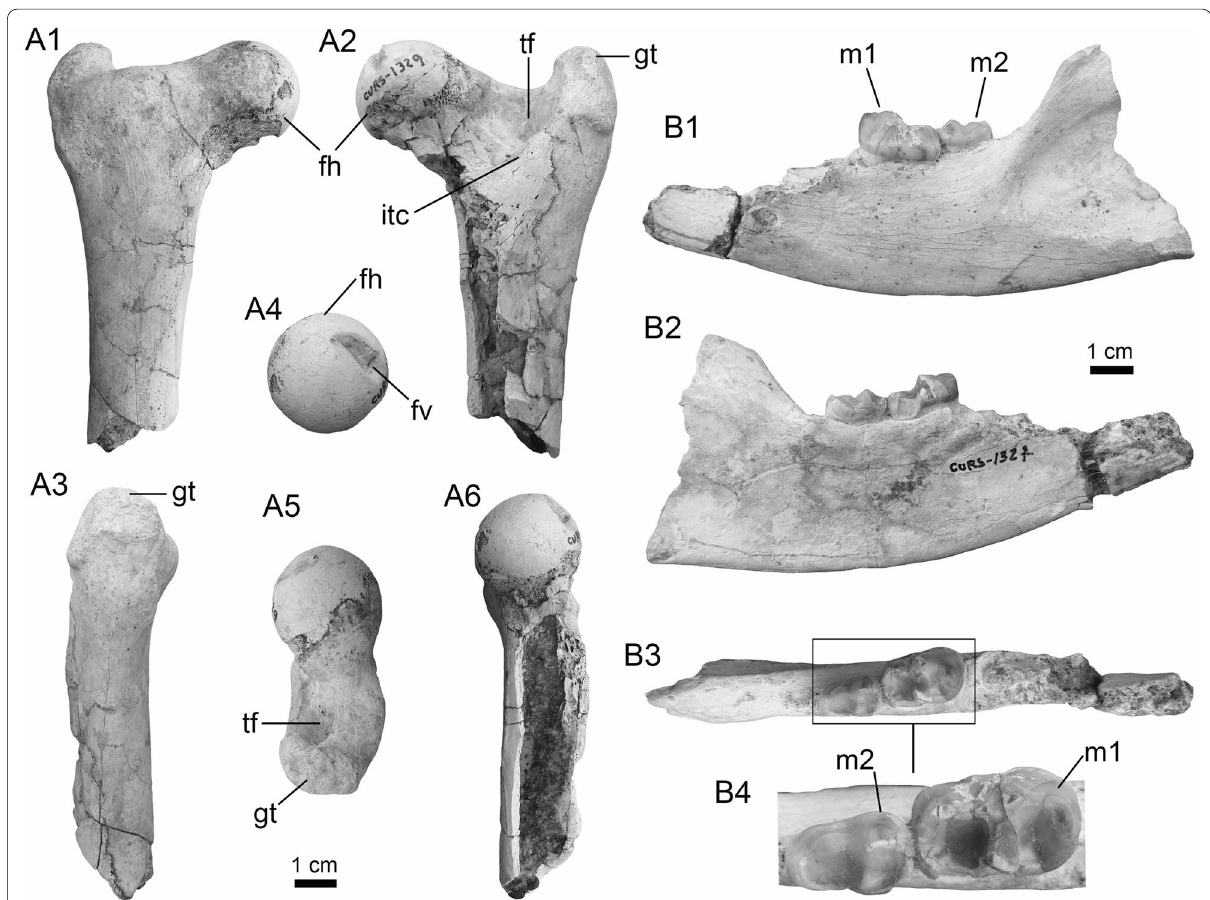
Fig. 28 Artiodactyla (Camelidae) and Carnivora (Procyonidae) from the Cocuiza Member. A1 – A5 Proximal portion of a right femur (AMU‑CURS‑1329) of Camelidae indet. B1 – B4 Partial left hemimandible (AMU‑CURS‑1327) of Chapalmalania sp. Views: anterior ( A1 ), lateral ( A3 , B1 ), proximal ( A5 ), medial ( A6 , B2 ), occlusal ( B3 , B4 ), posterior ( A2 ). fh femoral head, fv fovea, gt greater trochanter, itc intertrochanteric crest, tf trochanteric